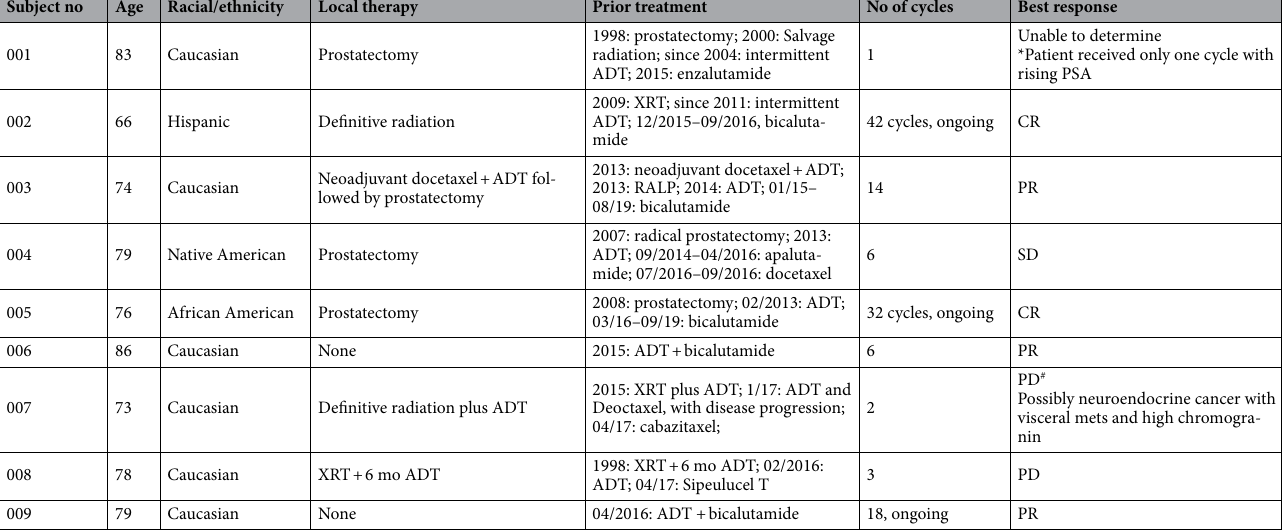
Table 1. Patient characteristics at the entry of the trial. CR complete response, PR partial response, SD stable disease, PD progression of disease. *Patient received only one cycle of treatment at the trial with rising PSA but without clinical progression and was taken off from the trial. Per PCWG2 criteria, if PSA is the only sign of disease progression, patient should be treated for up to 12 weeks. # This patient might have neuroendocrine tumor as he had widespread visceral metastasis and high serum